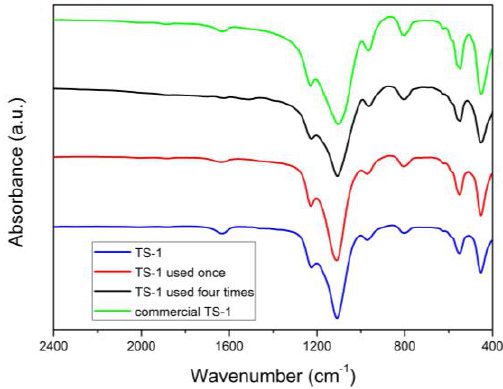
Figure 3. FT-IR spectra of TS-1, used TS-1, and commercial TS-1.